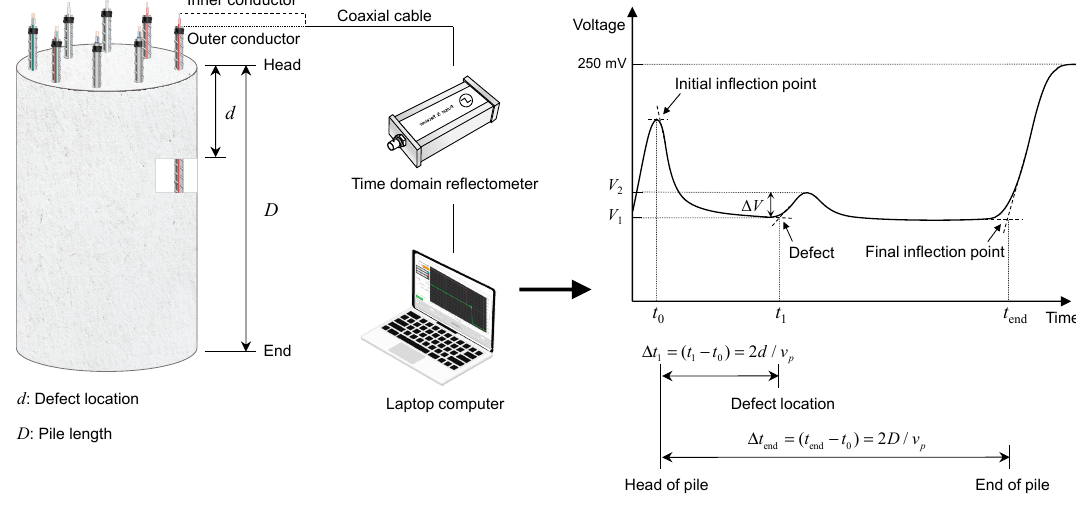
Figure 6. Measurement